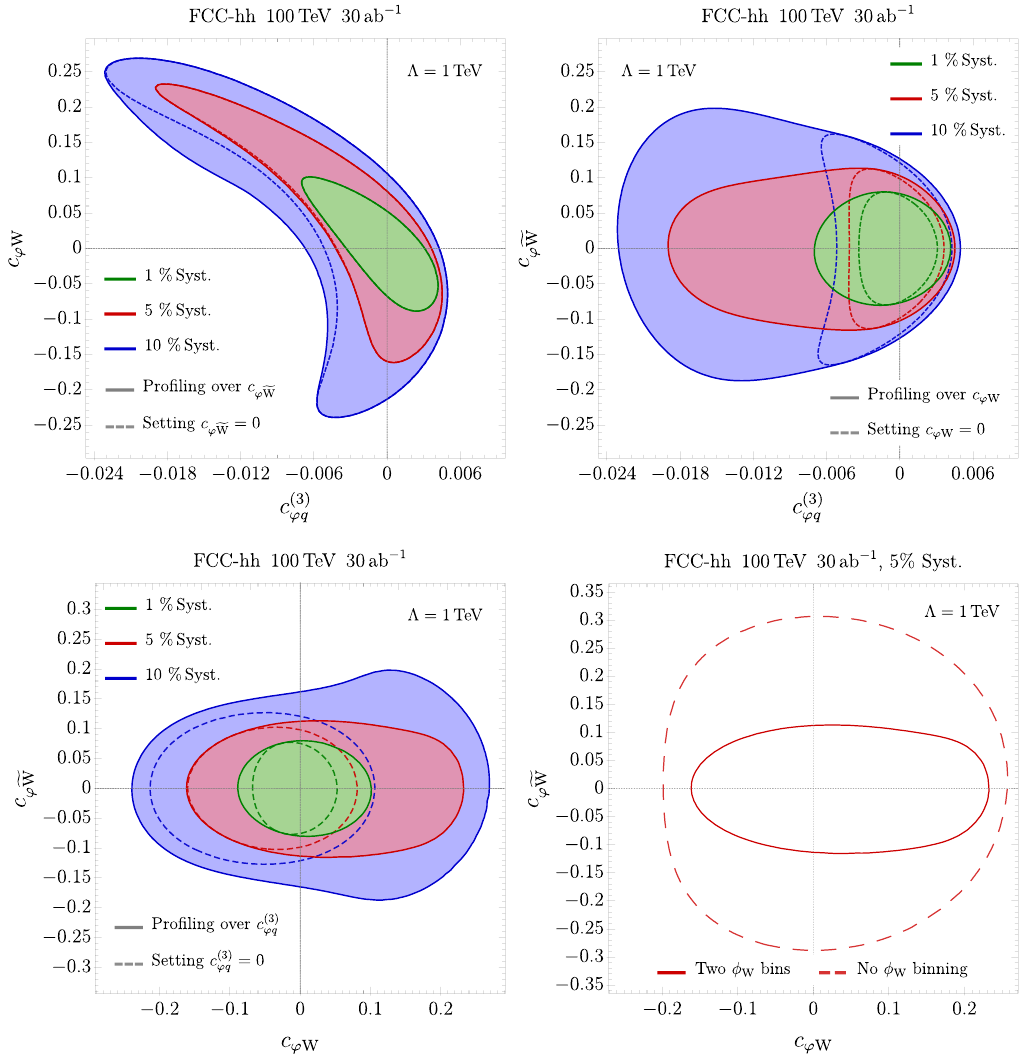
Figure 6 . Expected 95% C.L. bounds on c ’ w , c , c (3) ’q at the FCC-hh for 30 ab (cid:0) 1 . Bounds in ’ e w green, red, blue, assume 1%, 5% and 10% systematic error. Solid (dashed) lines in top and bottom left panels correspond to the bounds when pro(cid:12)ling over (setting to zero) the Wilson coe(cid:14)cient not appearing in the plot Top Left: bounds on the c ’ w , c (3) ’q plane. Top Right: bounds on the c , c (3) ’q ’ e w plane. Bottom Left: bounds on the c ’ w , c plane. Bottom Right: in solid red (dashed red) the ’ e w bounds when using (not using) the double di(cid:11)erential binning in (cid:30) W assuming 5% systematics in the plane c ’ w ; c ’ e w